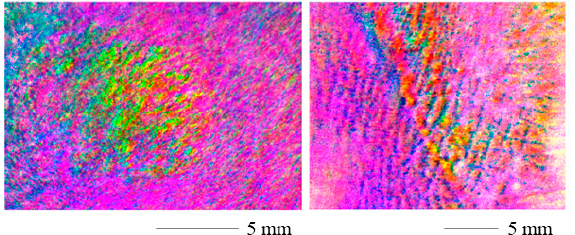
Figure 6. Range adjusted polarization stain image for a contracture scar ( left ) and a hypertrophic scar ( right ). The scarred areas are clearly distinguishable. The values shift toward the edges of the image and the curved skin geometry may be the cause of this.